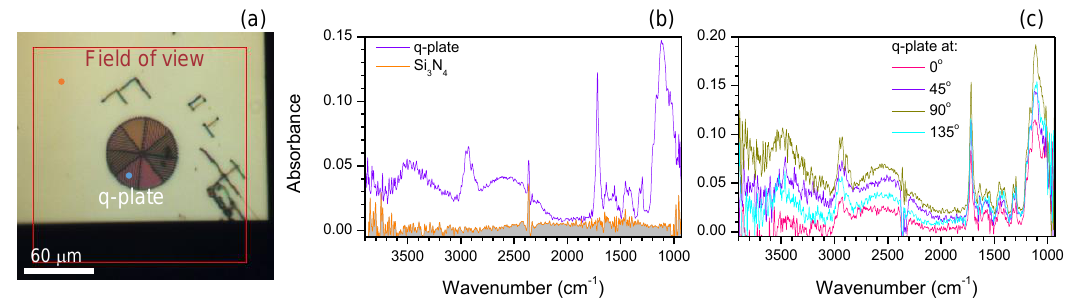
Figure 3. Polarisation dependence of the point spectrum of a q-plate; the light source is thermal-IR. ( a ) Optical image of a q-plate polymerised out of an SZ2080 resist on a Si 3 N 4 100-nm membrane. Two coloured markers show the location of the point spectrum measurement shown in ( b ). ( c ) Angular dependence of the point spectrum on the q-plate; θ = 0 ◦ is a horizontal